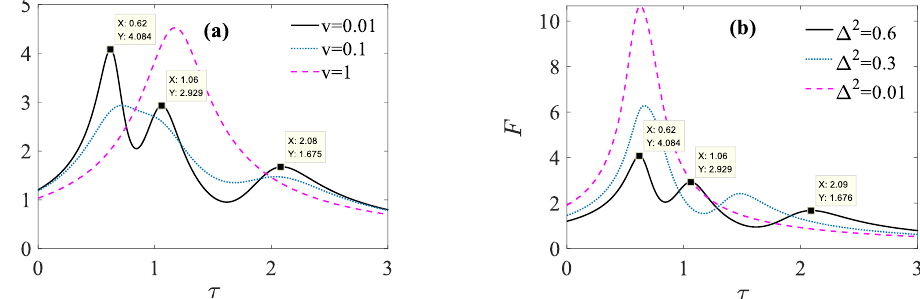
Figure 8. GSR induced by a delay in the system (12) under different correlation rate and intensity of noise ( a ) ∆ 2 = 0.6, ( b ) v = 0 . 01.